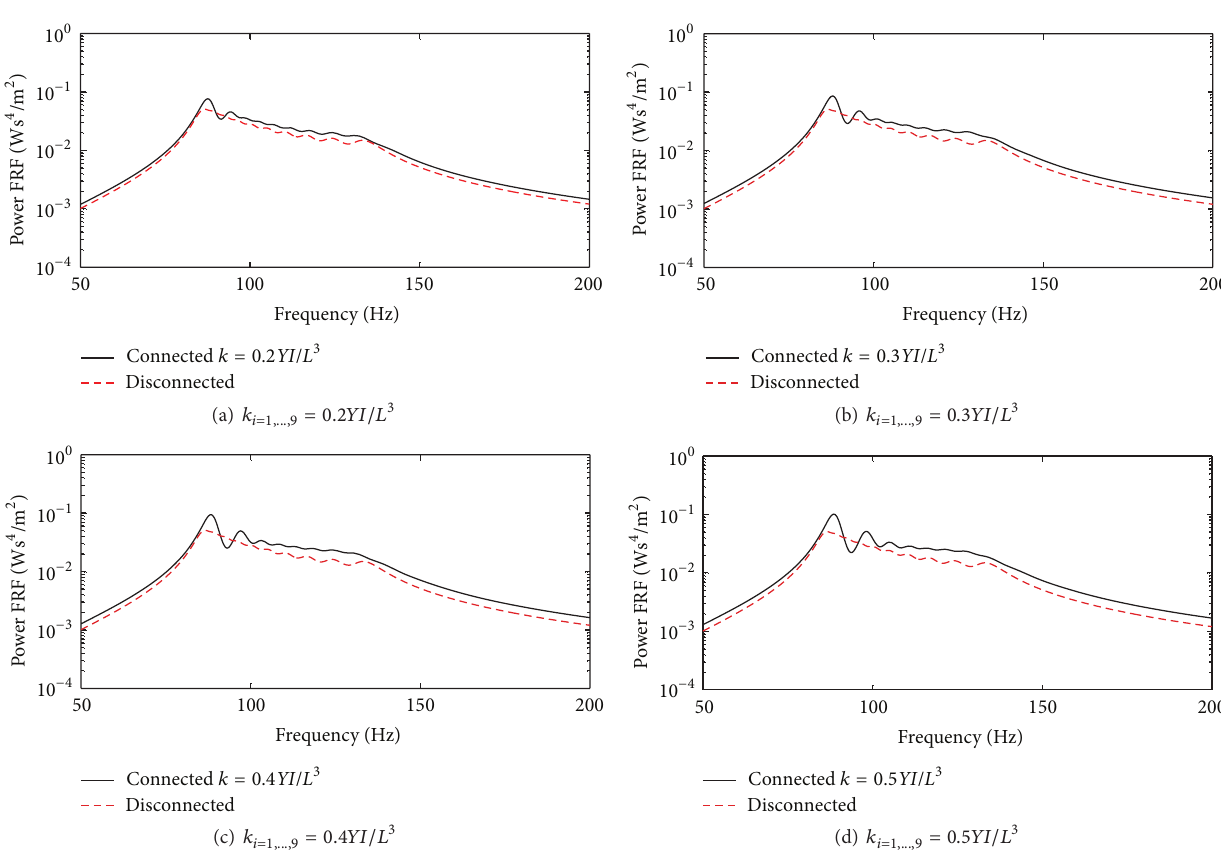
Figure 10: Power FRF with ten bimorph beams: 𝑀 𝑡,1 = 0.1𝑚𝐿 , 𝑀 𝑡,2 = 0.15𝑚𝐿 , 𝑀 𝑡,3 = 0.2𝑚𝐿 , 𝑀 𝑡,4 = 0.25𝑚𝐿 , 𝑀 𝑡,5 = 0.3𝑚𝐿 , 𝑀 𝑡,6 = 0.35𝑚𝐿 , 𝑀